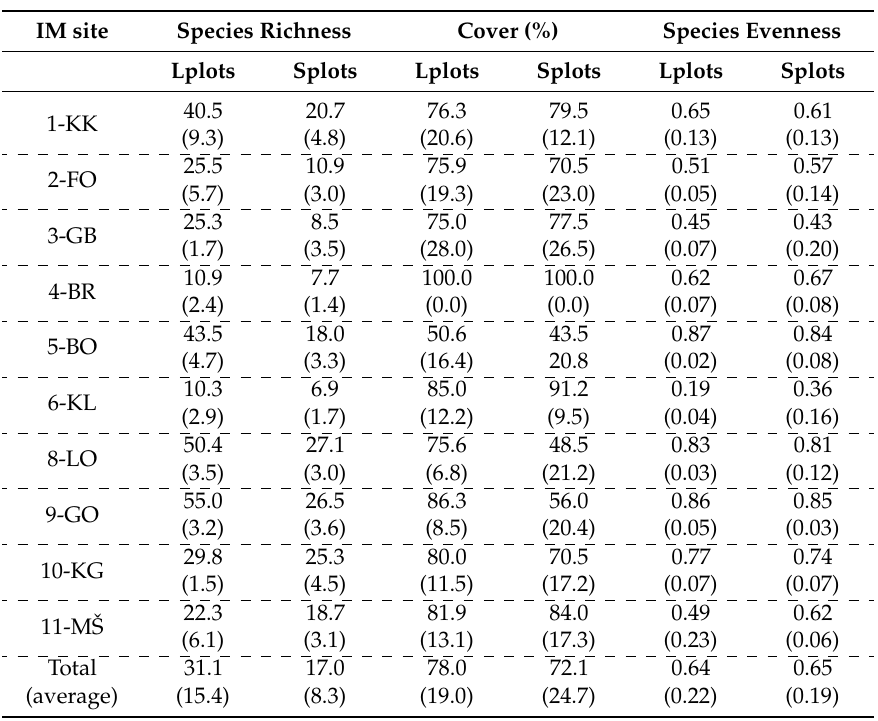
Table 2. Species richness (number of species per plot), understory cover (sum of shrub and herb layer) and species evenness for 10 IM forest sites in Slovenia. Results are shown for two di ff erent spatial scales (plot sizes): large plots (Lplots, 100 m 2 ) and small plots (Splots, 4 m 2 ). Values are mean ± SD. For abbreviations of IM sites, see Table 1.